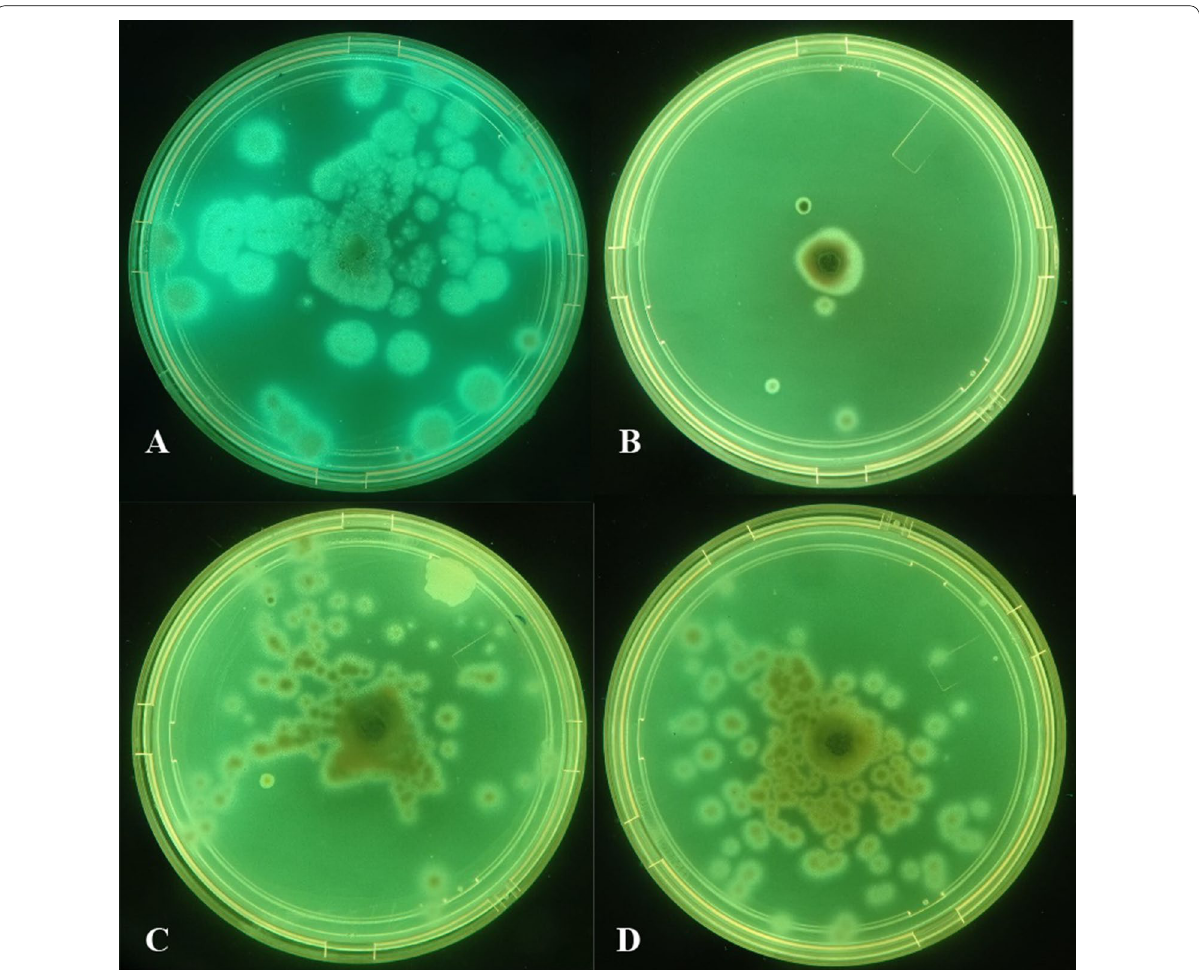
Fig. 5 Fluorescence of 5 days old Aspergillus isolate grown on YES medium supplemented with 2% of methylated ß-cyd observed under UV